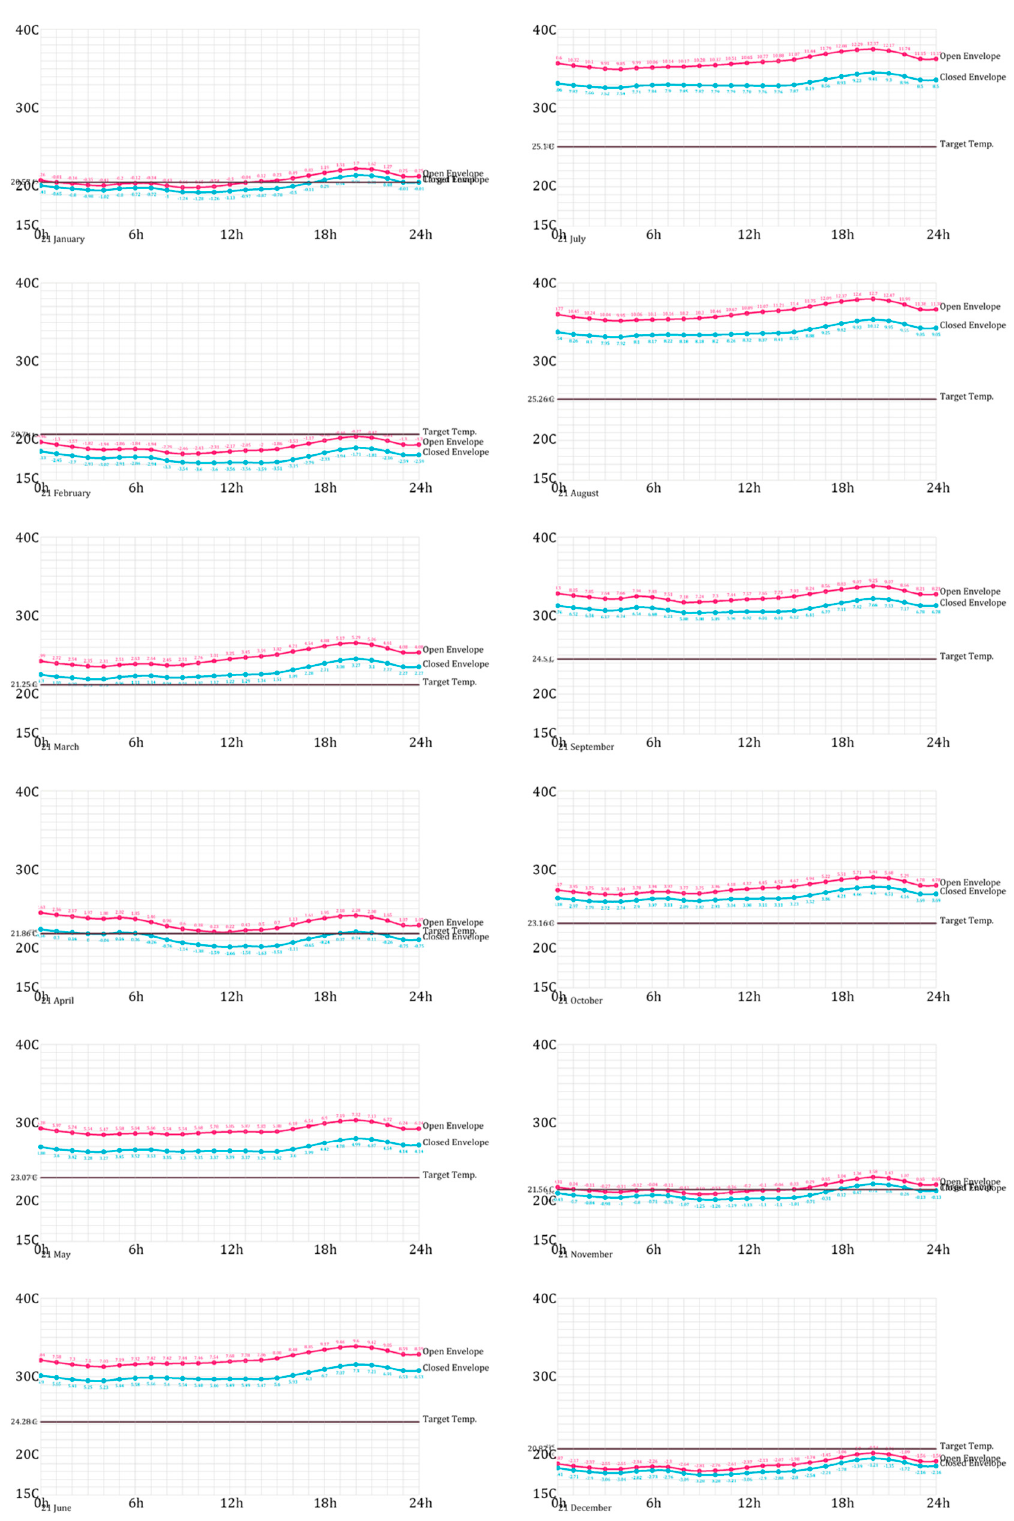
Figure 3. Temperature graphs of each of the 12 months showing thermal deviation from the calculated adaptive comfort temperature in response to the operable element’s composition. Graph x-, y-axis values are kept the same as in Figure 3 to allow direct visual comparison between months.